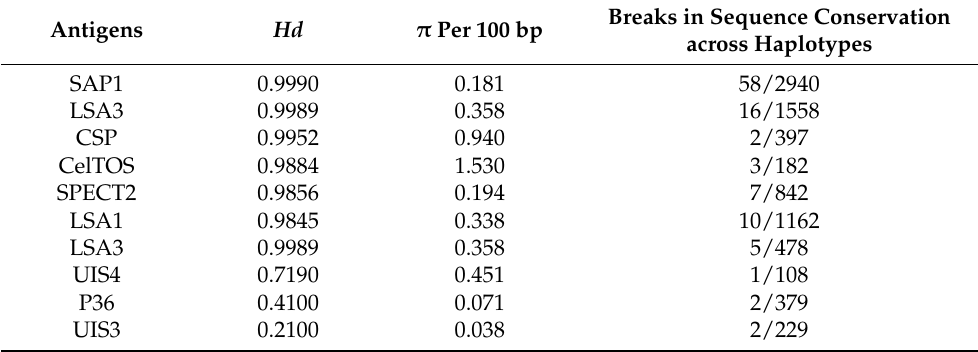
Breaks in Sequence Conservation across Haplotypes